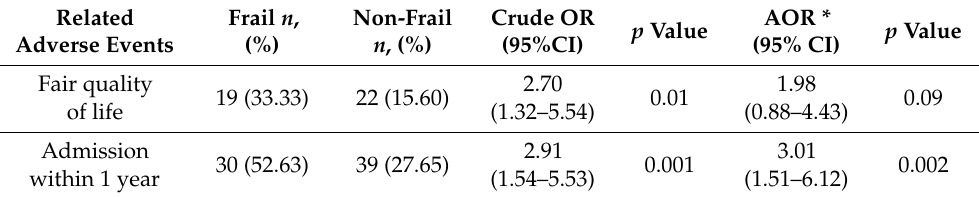
Table 2. Comparison of related adverse events between frail and non-frail older adults. Related Adverse